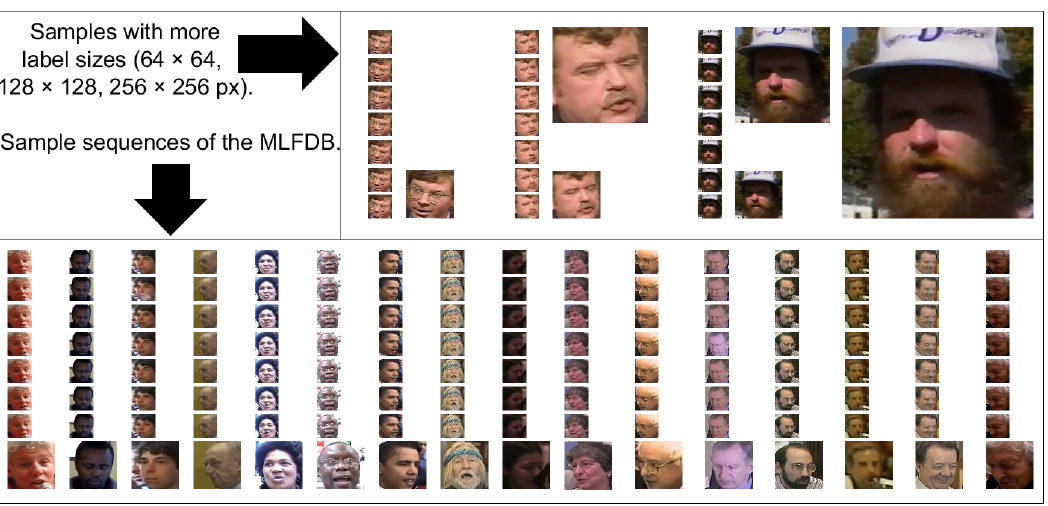
Figure 9. An example of sequence samples of the